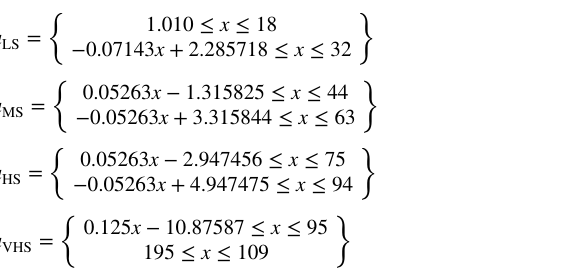
Table 2 Membership function and extent–universe storage (S)